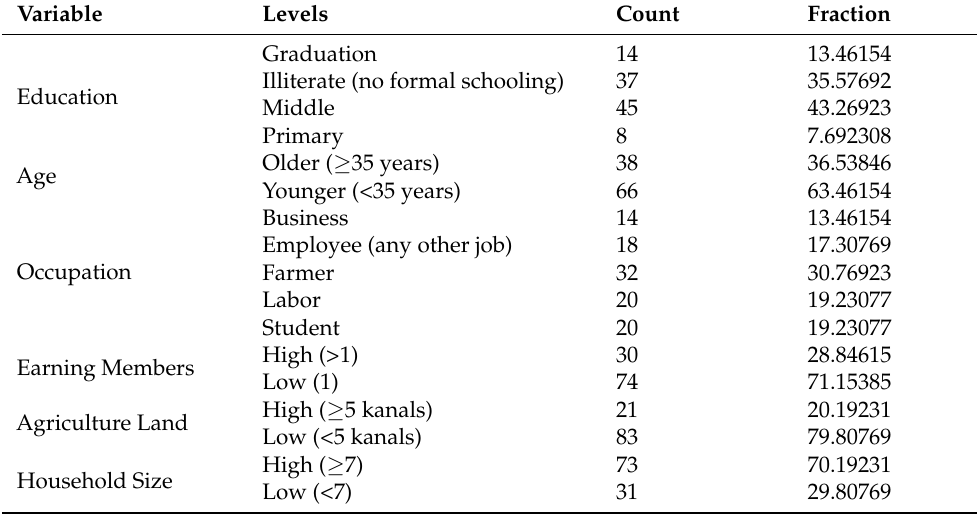
Table 3. Factors associated with attitude towards the wolf ( n = 104) are presented. Values shown include the number of respondents for each level (counts) and the percentages for each factor.